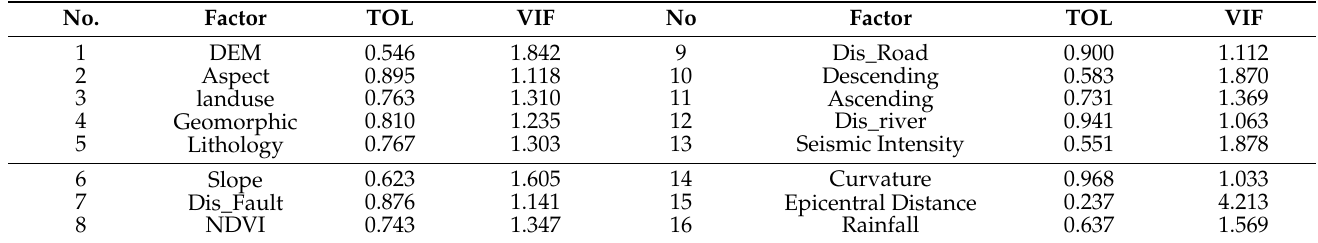
Table 3. Multicollinearity analysis of landslide susceptibility assessment factors.